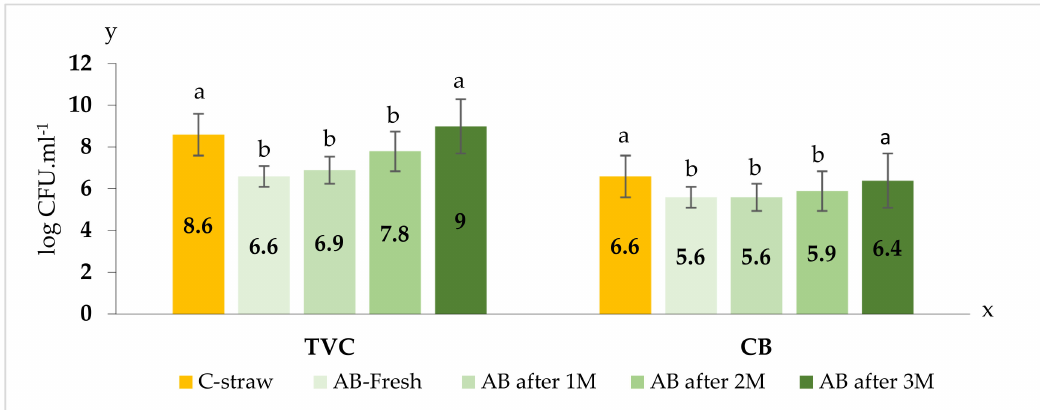
Figure 8. Comparison of improved bedding and straw bedding on indicator microorganisms (total viable count, TVC, and coliform bacteria, CB) regarding the level of hygiene. Note: C straw—control cubicles were not emptied of straw bedding, but the cubicles were re-bedded once a day with fresh straw; AB-Fresh—cubicles bedded with one day old (fresh) alternative bedding; AB after